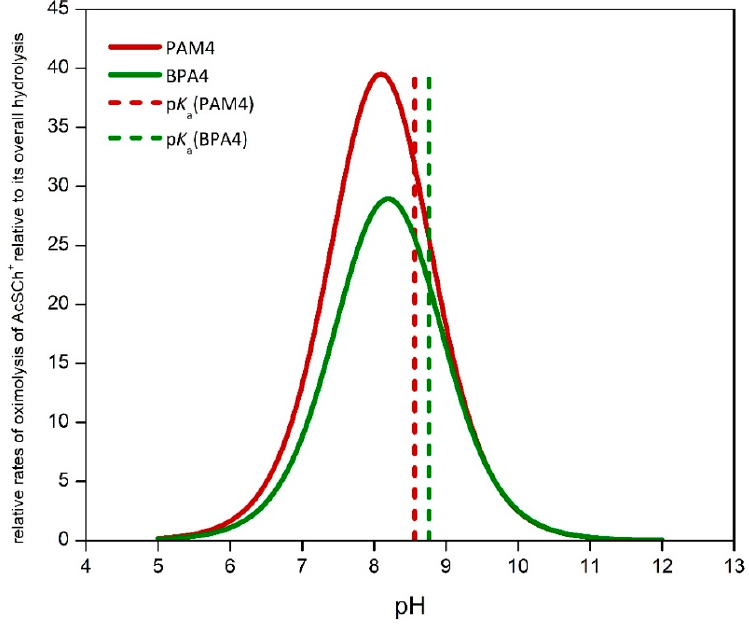
Figure 3. Plots of the calculated ratio of the observed rates of AcSCh + oximolysis and aqueous overall hydrolysis as a function of pH. The relative rates were calculated as the ratio of Equations (3) and (5). The total concentration of AcSCh + was 4 mM.